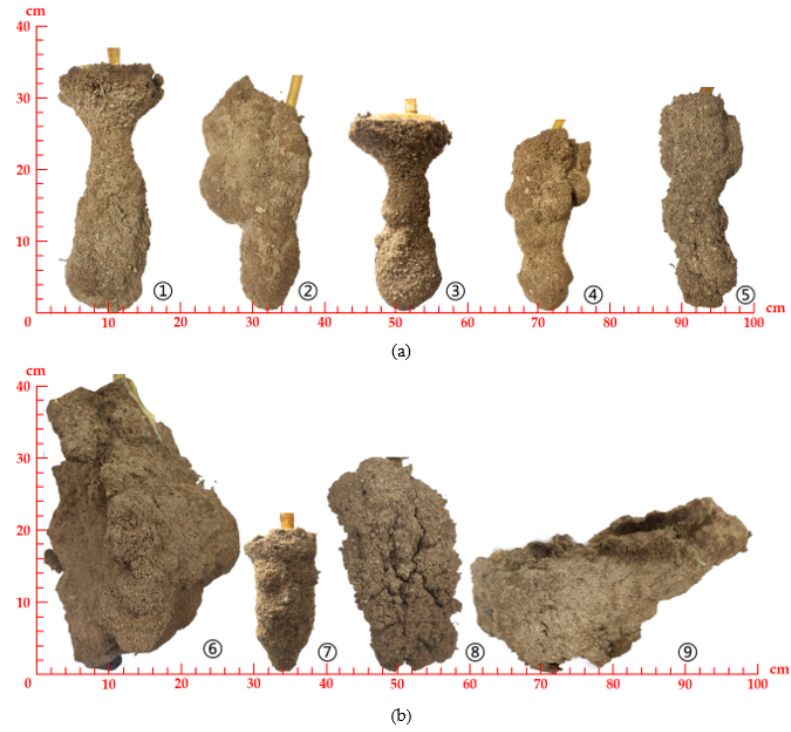
Figure 10. Chemical grouted sands chart: ( a ) test 1–5; ( b ) test 6–9.